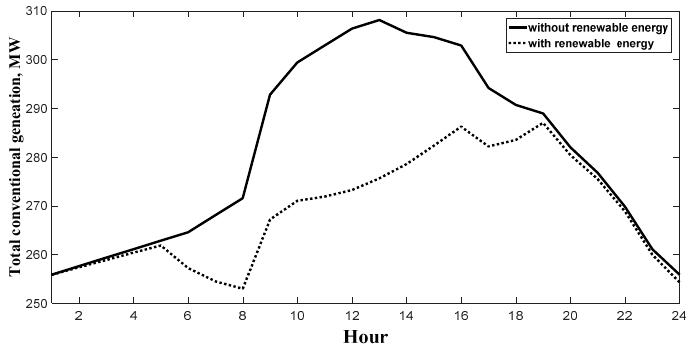
Figure 5. Total conventional energy generation with and without renewable energy generation.